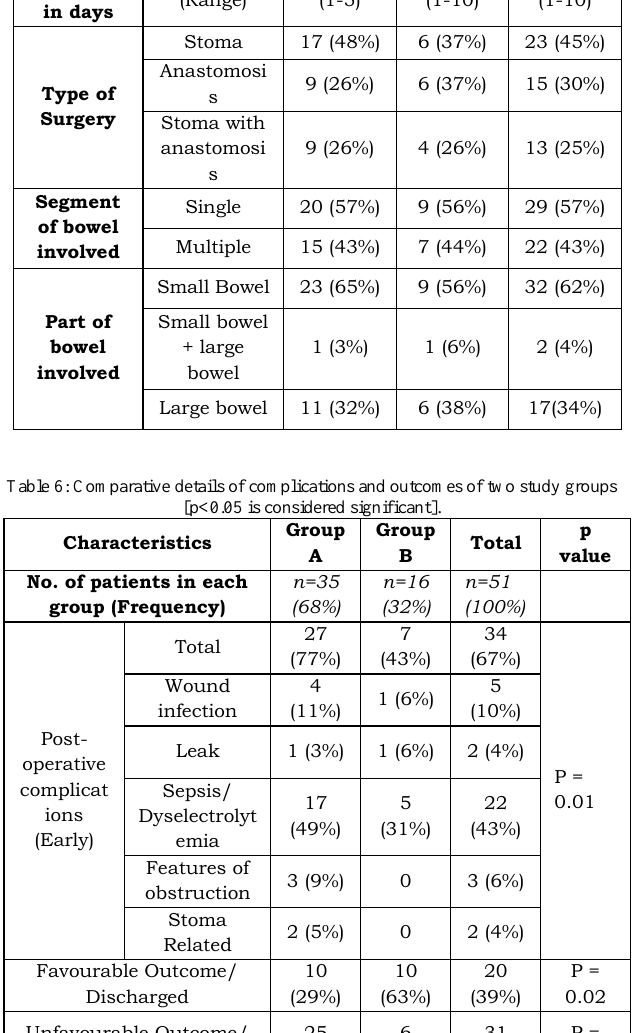
Table5: Comparative operative details of two study groups Characteristics Group A